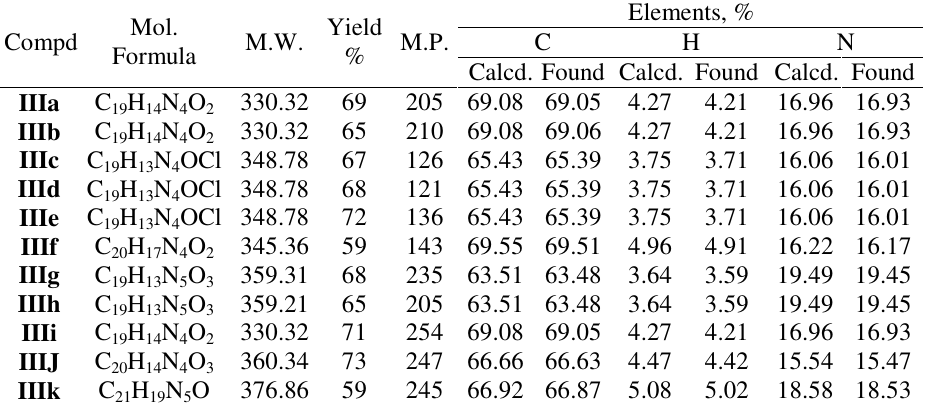
Table 1. Physical characterization data of synthesized compounds III(a-k)